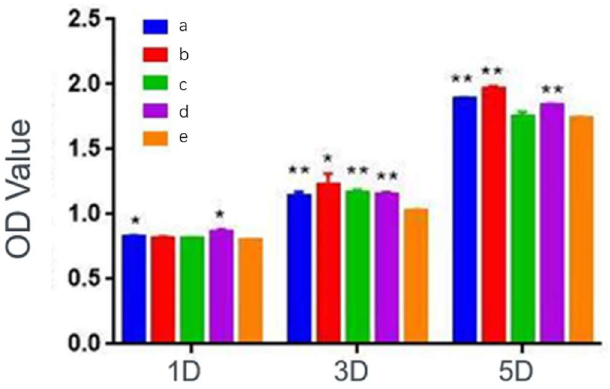
Figure 8. OD value after 1, 3, and 5 days of culture with bone marrow mesenchymal stem cells (BMSC). Notes: ( a ) groove pattern; ( b ) micro-hole pattern; ( c ) directional grain pattern; ( d ) stripe pattern ( e ) control group. Abbreviations: OD, optical density, * p < 0.1, ** p <